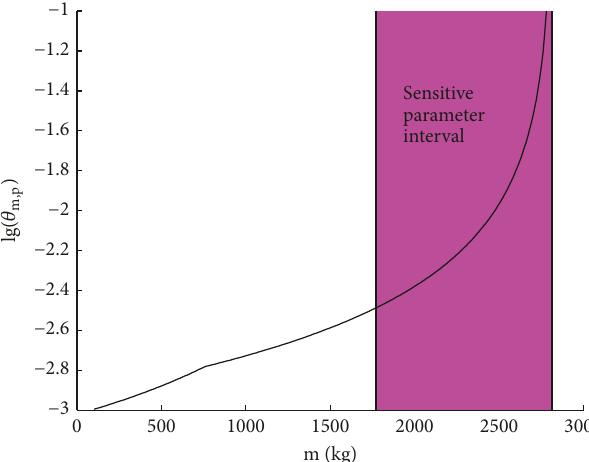
Figure 18: Influence of m on resonant peak.